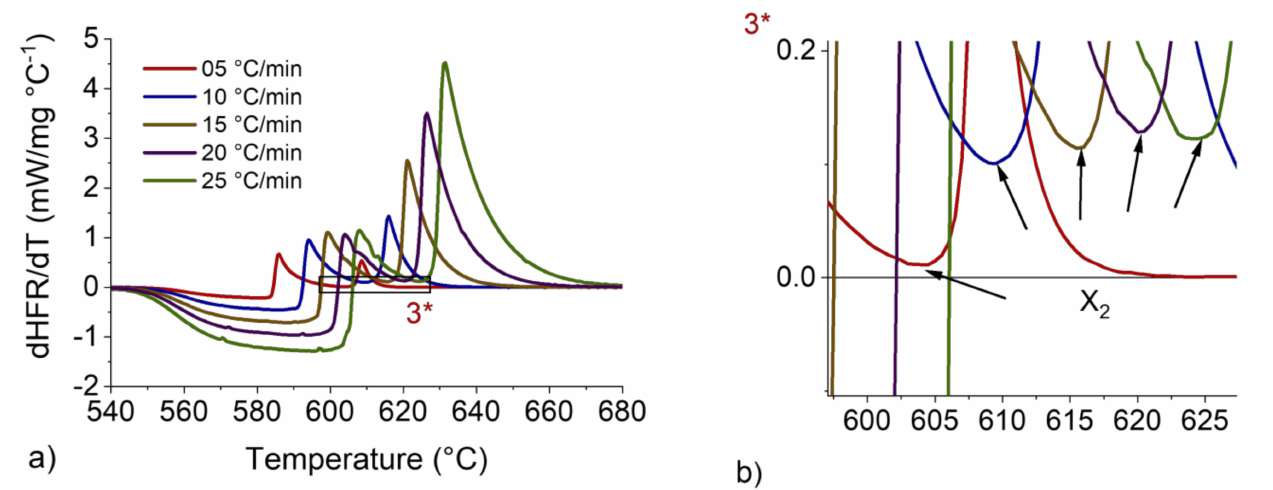
Figure 8. dHFR/dT vs. T curve for 7 wt.%Si with heating rates from 5 to 25 ◦ C/min and sample mass of 200 mg ( a ). Magnification at the ∆ T THIXO zone ( b ).